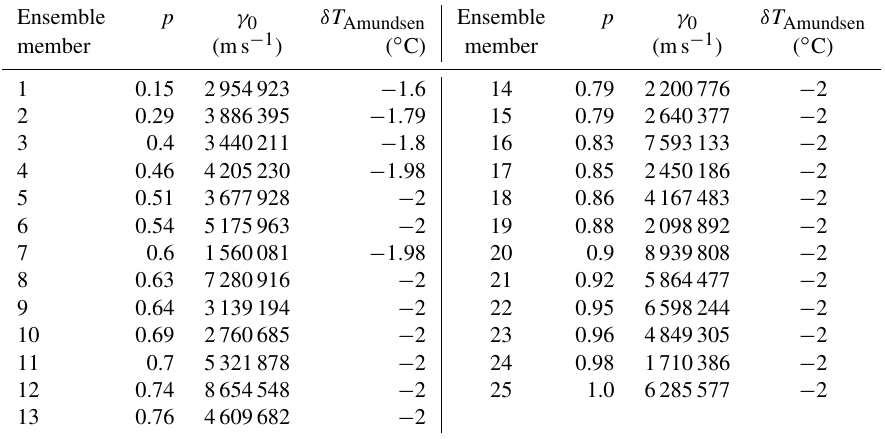
Table 3. p and γ 0 combinations for each ensemble member, along with the δT Amundsen , showing the end-of-spin-up correction factor needed for this region.